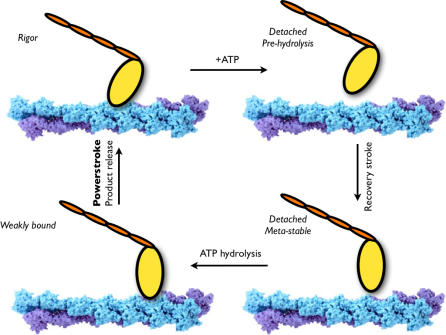
The Lymn–Taylor Functional Cycle of Myosin-II–Actin [13–17]Only a myosin monomer is shown for simplicity. The binding of ATP to the actin–myosin complex (the “rigor state”) leads to rapid dissociation of myosin from actin without immediate hydrolysis of ATP. Coupled with a major structural change in the orientation of the lever arm (recovery stroke), ATP hydrolysis proceeds, after which the motor domain rebinds to actin weakly. Following the release of Pi, the motor domain undergoes “powerstroke” during which the orientation of the lever arm changes back to that in the “rigor state” and the motor domain becomes strongly bound to actin. Dissociation of ADP leads the system back to the “rigor state.” Note that the sum of free-energy drops in an entire cycle is equal to the hydrolysis free energy of ATP in solution, which is the ultimate thermodynamic driving force of the system.